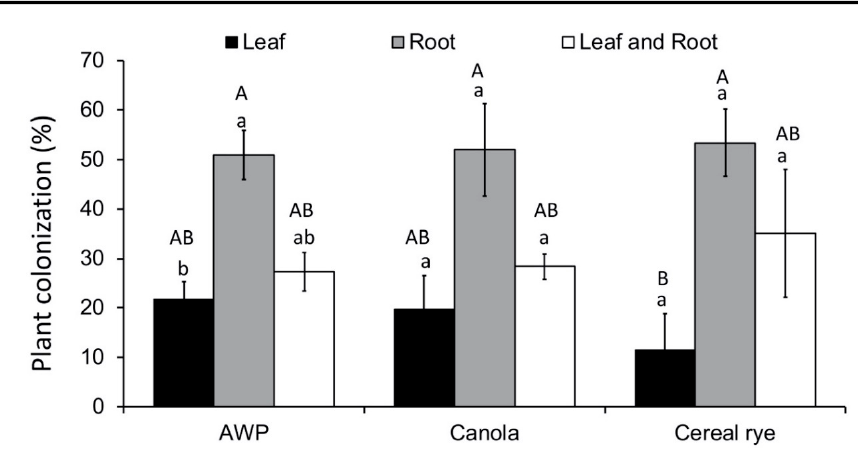
Figure 1. Percentage of plants grown from M. robertsii -inoculated seeds from which endophytic growth was detected in only leaf, only root or both leaf and root tissues in Austrian winter pea (AWP) ( n = 30), cereal rye ( n = 38) and canola ( n = 26). The error bars represent ± standard error of the mean. The lowercase letters show the difference for leaf only, root only and both leaf and root within a cover crop species. The uppercase letters show the differences for leaf only, root only and both leaf and root groups among cover crop species. The bars sharing common letters are not significantly different at p = 0.05.